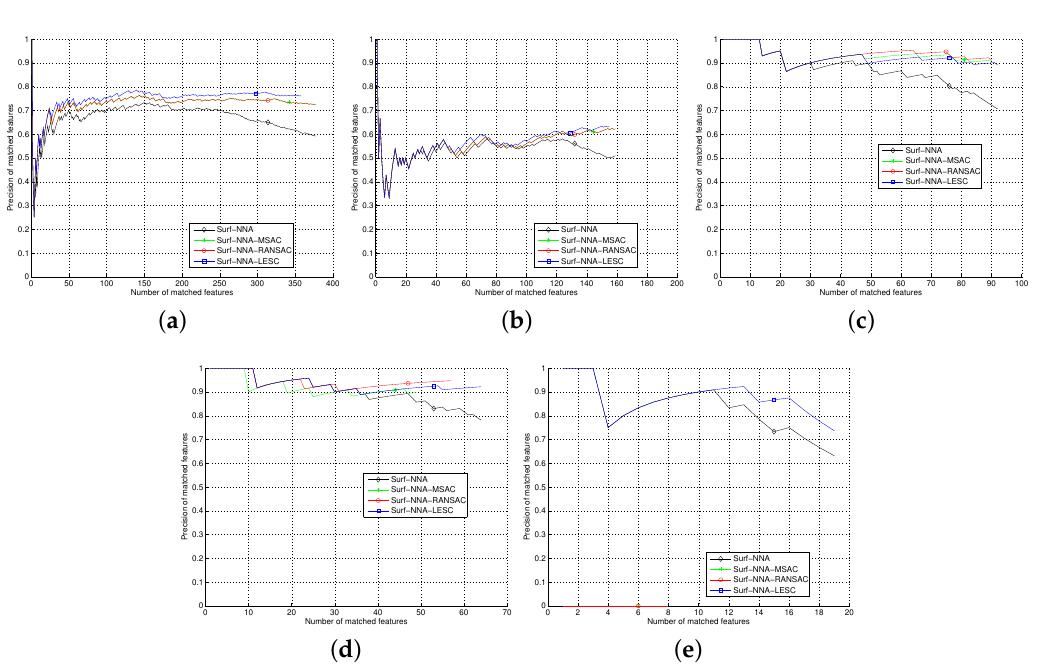
Figure 1. Scale change for the textured scene by the Bark sequence. From ( a ) to ( e ) the degree of change